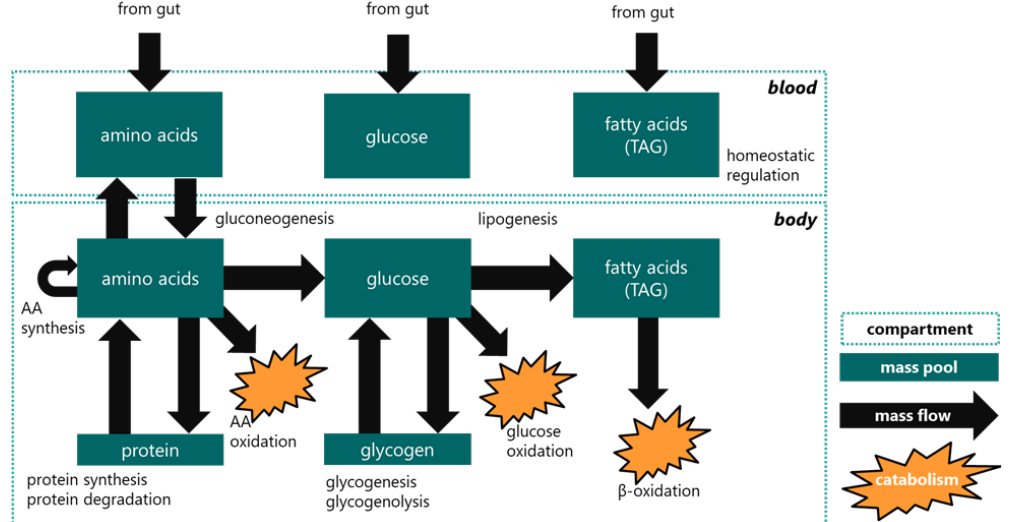
Figure A3. Diagram detailing the internal structure of the blood and body compartments, showing the different pools considered, along with mass flows between pools. For simplicity, the amino acid and fatty acid pools are displayed in vectorized form (i.e., they appear as a single unit, but actually represent 20 different pools each).